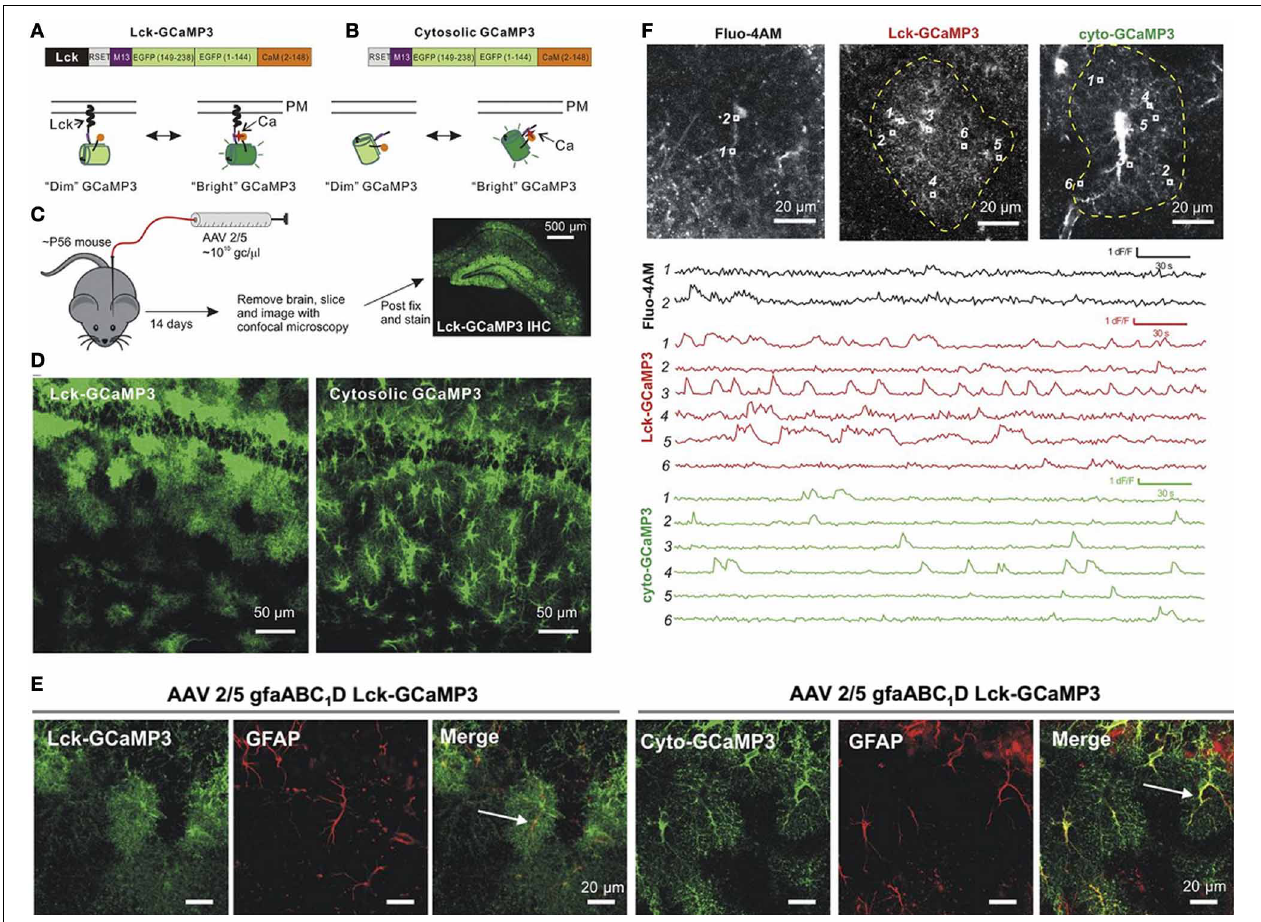
FIGURE 1 | Expression of GCAMP3 in astrocytes and comparison of Ca 2 + signals detected with Fluo-4, cyto-GCAMP3, and Lck-GCAMP3. (A,B) Illustration of the membrane-targeted Lck-GCAMP3 and cytosolic non-targeted Cyto-GCAMP3. (C) Protocol of AAV2/5 injections into a mouse hippocampus. (D) Confocal images in CA1 stratum radiatum for Lck-GCaMP3 and cyto-GCaMP3. (E) Colocalization between Lck-GCaMP3 and